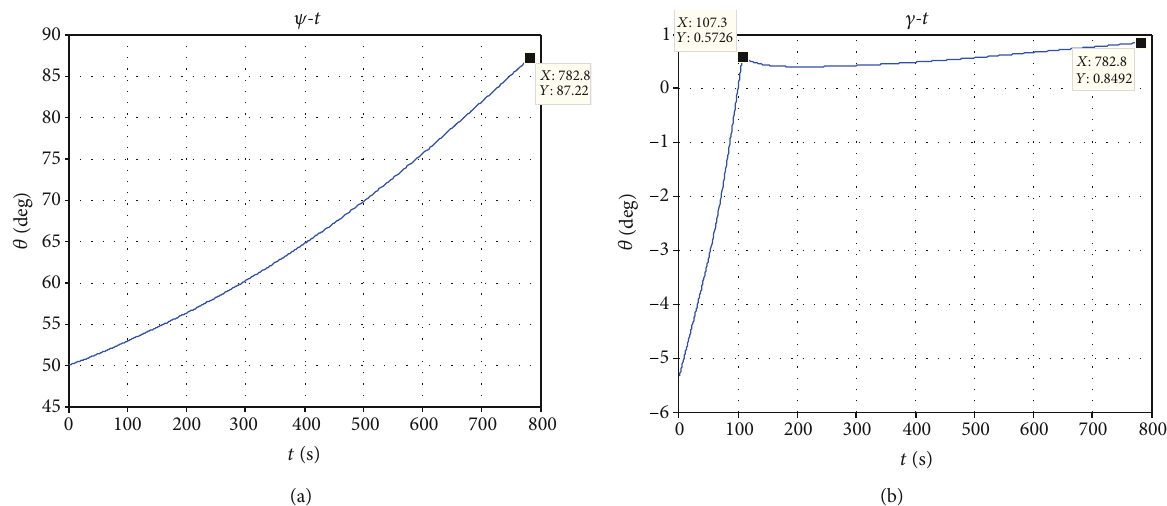
Figure 10: Time history of (a) heading angle ψ and (b) fl ight-path angle γ .